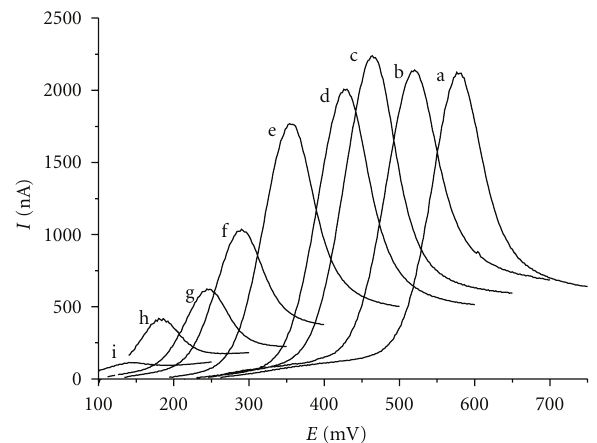
Figure 2: Linear sweep voltammogramms of 0.1mM rutin in Bri- tton-Robinson bu ff ers measured on CPE at scan rate of 100 mV s − 1 .